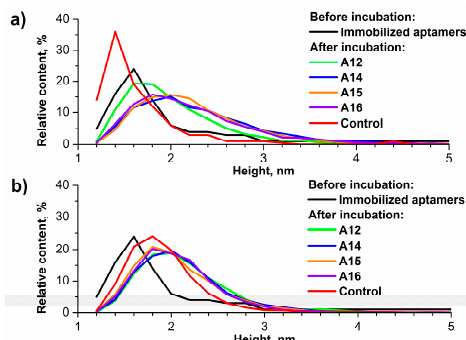
Figure 2. Plots of the density functions of visualized objects ρ (h) obtained before and after incubation of the chip with the ‘positive’ ( a ) and ‘negative’ ( b ) serum samples. Density functions ρ (h) correspond to the working area of the chip with immobilized A12 (green line), A14 (blue line), A15 (orange line), and A16 (violet line) aptamers and to the control area (red line) after incubation. Black lines correspond to density functions for all working sensor areas before incubation.